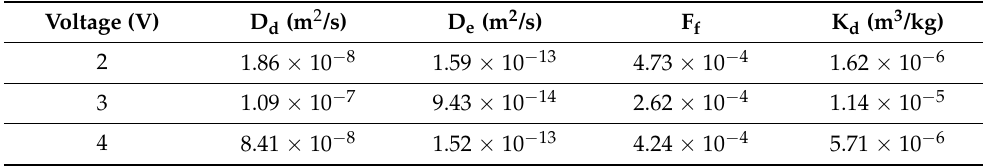
Table 6. Parameter evaluation of the breakthrough curves of Co 2+ migrating through the rock sample using the advection-dispersion